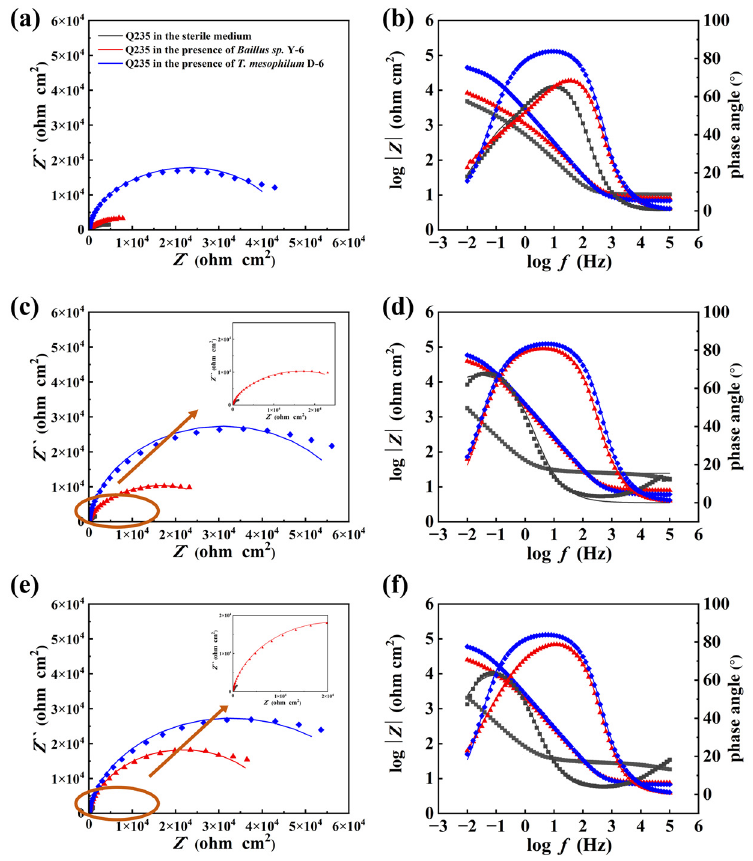
Figure 3. Nyquist ( a , c , e ) and Bode ( b , d , f ) plots of Q235 coupons immersed in the different culture media at 1, 4 and 7 days. Insertions in c and e are enlarged pictures of the left bottom corner.